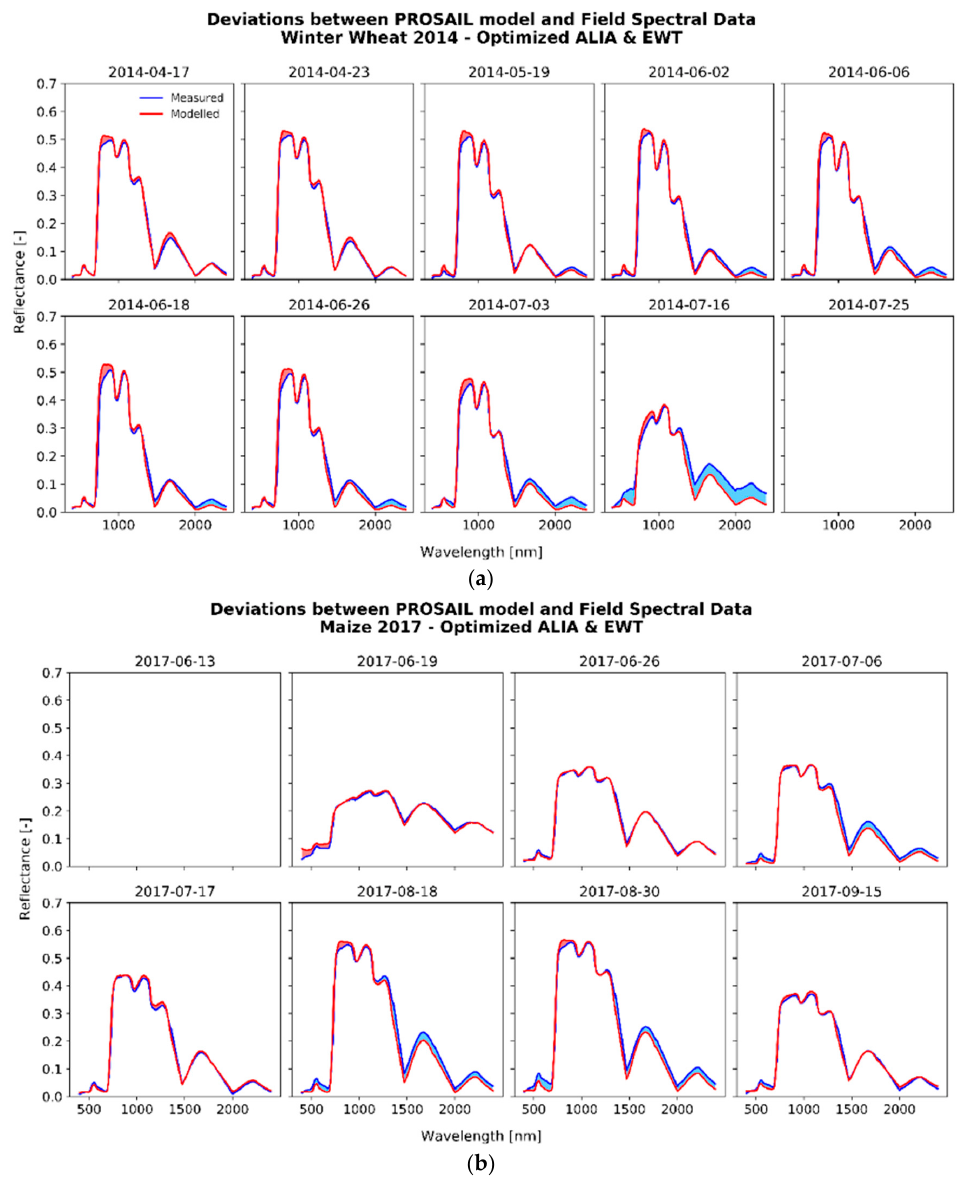
Figure 6. In the first step of the optimization, ALIA and EWT were fitted in the NIR region. This is demonstrated for winter wheat season 2014 ( a ) and silage maize season 2017 ( b ).